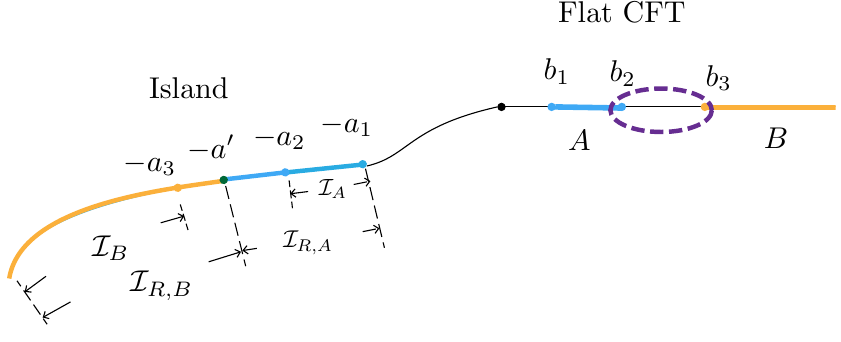
Figure 16 . Phase-D4 for JT gravity. The purple dashed circle denotes the boundary gap between A ∪ I R ( A ) and B ∪ I R ( B ) . a 0 denotes the island cross-section.